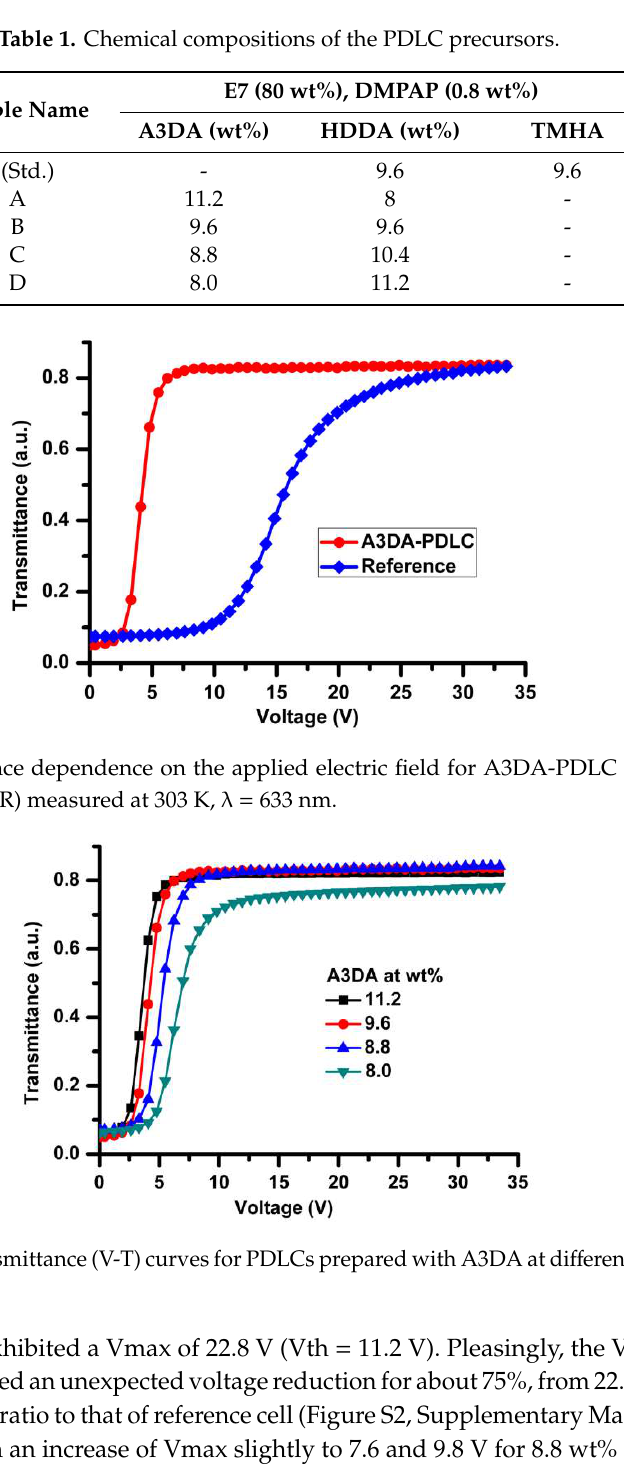
Figure 3. Voltage‐transmittance (V‐T) curves for PDLCs prepared with A3DA at different concentrations at 303 K, λ = 633 nm.